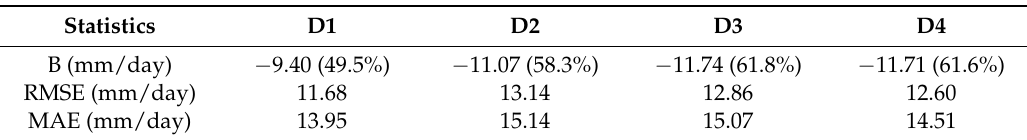
Table 3. Statistics of verification for the 4 simulated domains, average of all stations. In parentheses are the percentages of